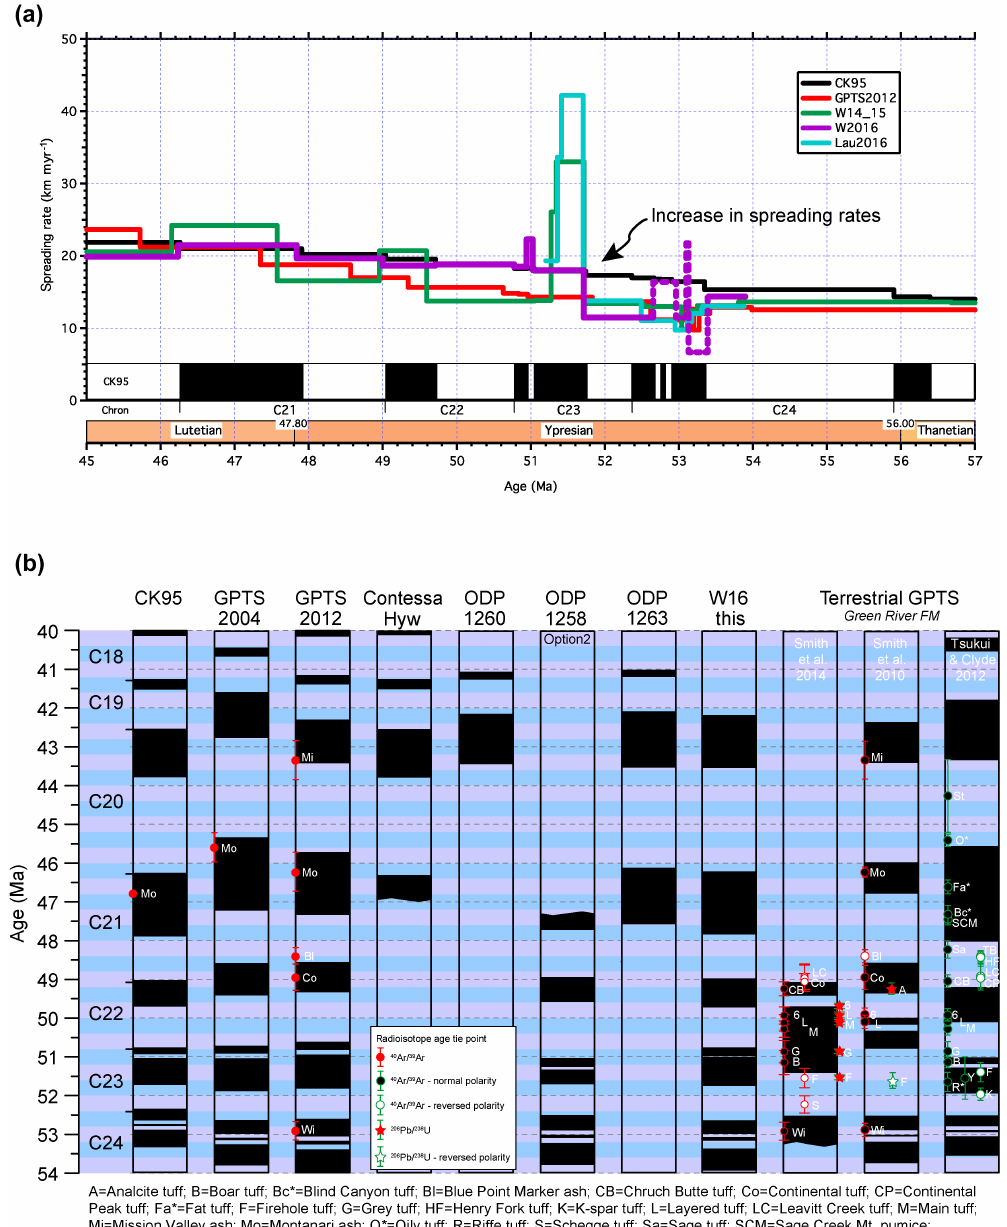
Figure 6. (a) Comparison of calculated spreading rates for the synthetic South Atlantic profile of Cande and Kent (1992) based on the age model of Cande and Kent (1995), GPTS2012 (Vandenberghe et al., 2012), Westerhold et al. (2015), Lauretano et al. (2016), and this study (W2016). The GPTS of CK95 is also plotted for reference. Note the increase in spreading rates in the South Atlantic at ∼ 52Ma based on the new GPTS presented in this study. (b) Geomagnetic polarity timescale of CK95 (Cande and Kent, 1995), GPTS2004 (Ogg and Smith, 2004), and GPTS2012 (Ogg, 2012; Vandenberghe et al., 2012) compared to astronomical calibrations of magnetochrons from Contessa Highway (Jovane et al., 2010), Site 1260 (Westerhold and Röhl, 2013), Site 1258 (Westerhold and Röhl, 2009; Westerhold et al., 2012), Site 1263 (Westerhold et al., 2015), and the new Ypresian GPTS (this study, W16) from 40 to 54Ma. Terrestrial calibration of the GPTS from the Green River Formation (Smith et al., 2010, 2014; Tsukui and Clyde, 2012) is also shown. Small red dots with error bars mark the radioisotopic calibration points used for CK95, GPTS2004, GPTS2012, and Smith et al. (2010); green circles show calibration points for the terrestrial sections used by Tsukui and Clyde (2012). The overview demonstrates the now consistent Eocene GPTS from 30 to 54Ma from ODP stratigraphic data and the discrepancy in the terrestrial GPTS. See text for